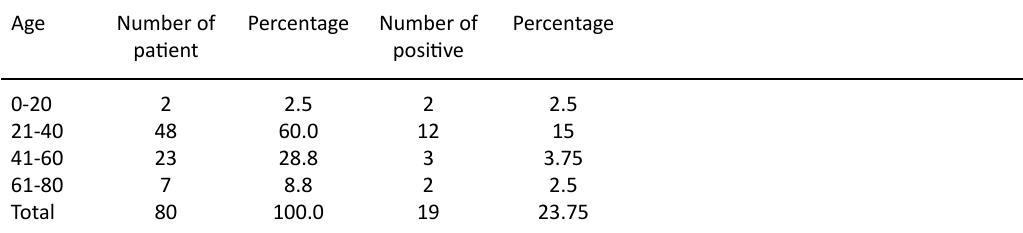
Total Table 4. Showing parasitic infection with associating CD4 + T cell count among HIV seropositive patients CD4 + T Cell N=80 Intestinal Odd ratio count